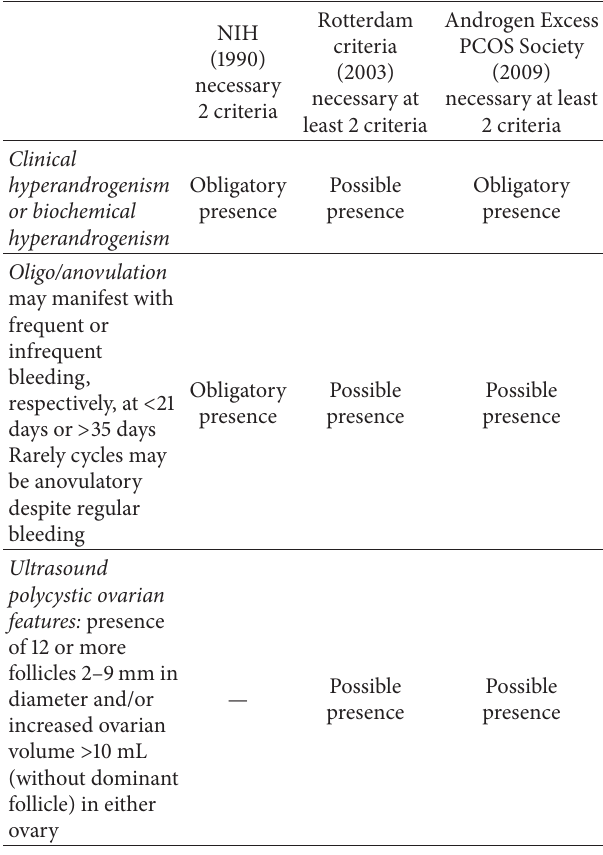
Table 1: Diagnostic criteria of PCOS according to different defini-